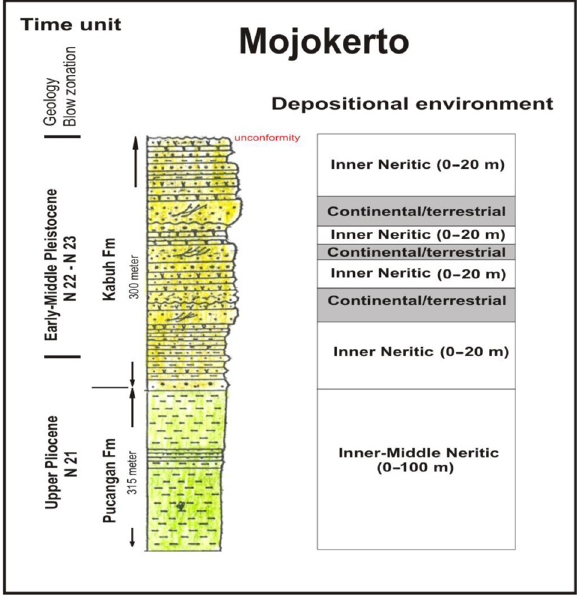
Figure 9. Pucangan and Kabuh Formations at Mojokerto [22].